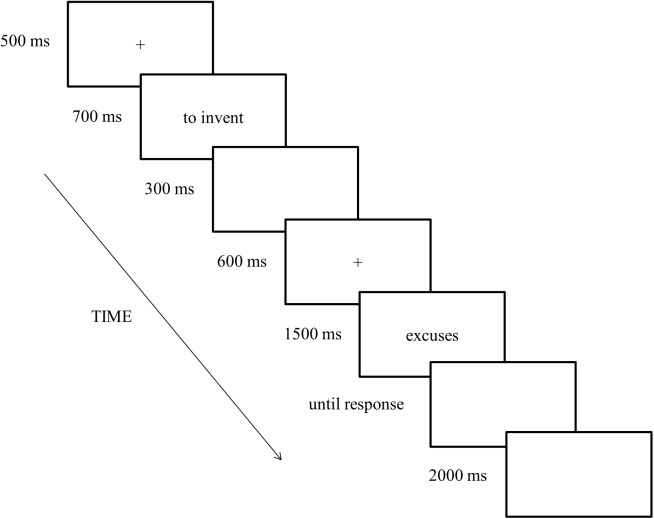
Time sequence of stimulus presentation.